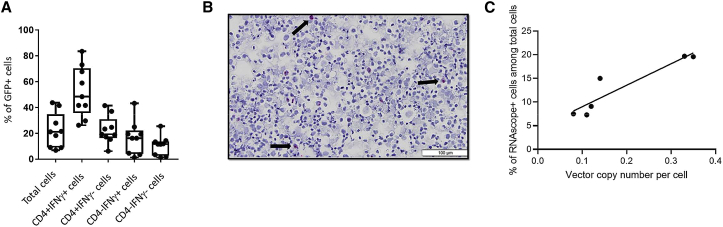
Evaluation of Lentivirus Transduction Efficiency(A) Percentage of lentivirus AGT103-GFP-transduced cells among total cells or different subsets (see also Figure S7). Boxplots show all points (min to max) and mean. (B) A representative image of RNAScope to detect AGT103-transduced cells. (C) Correlation between percentage of transduced cells by RNAScope and average vector copy number per cell.